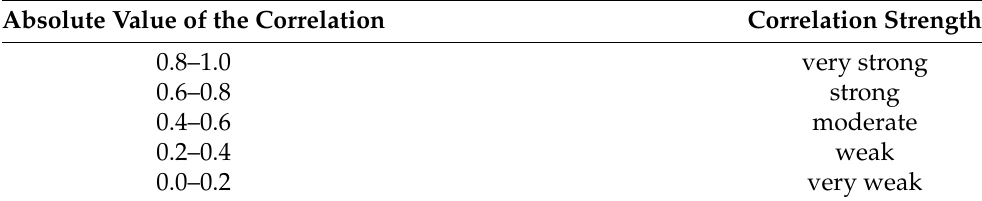
Table A1 contains ranges for the absolute values of the r-Pearson correlation coefficient and their interpretations. Table A1. The absolute values of the Pearson’s correlation coefficient and their significance.